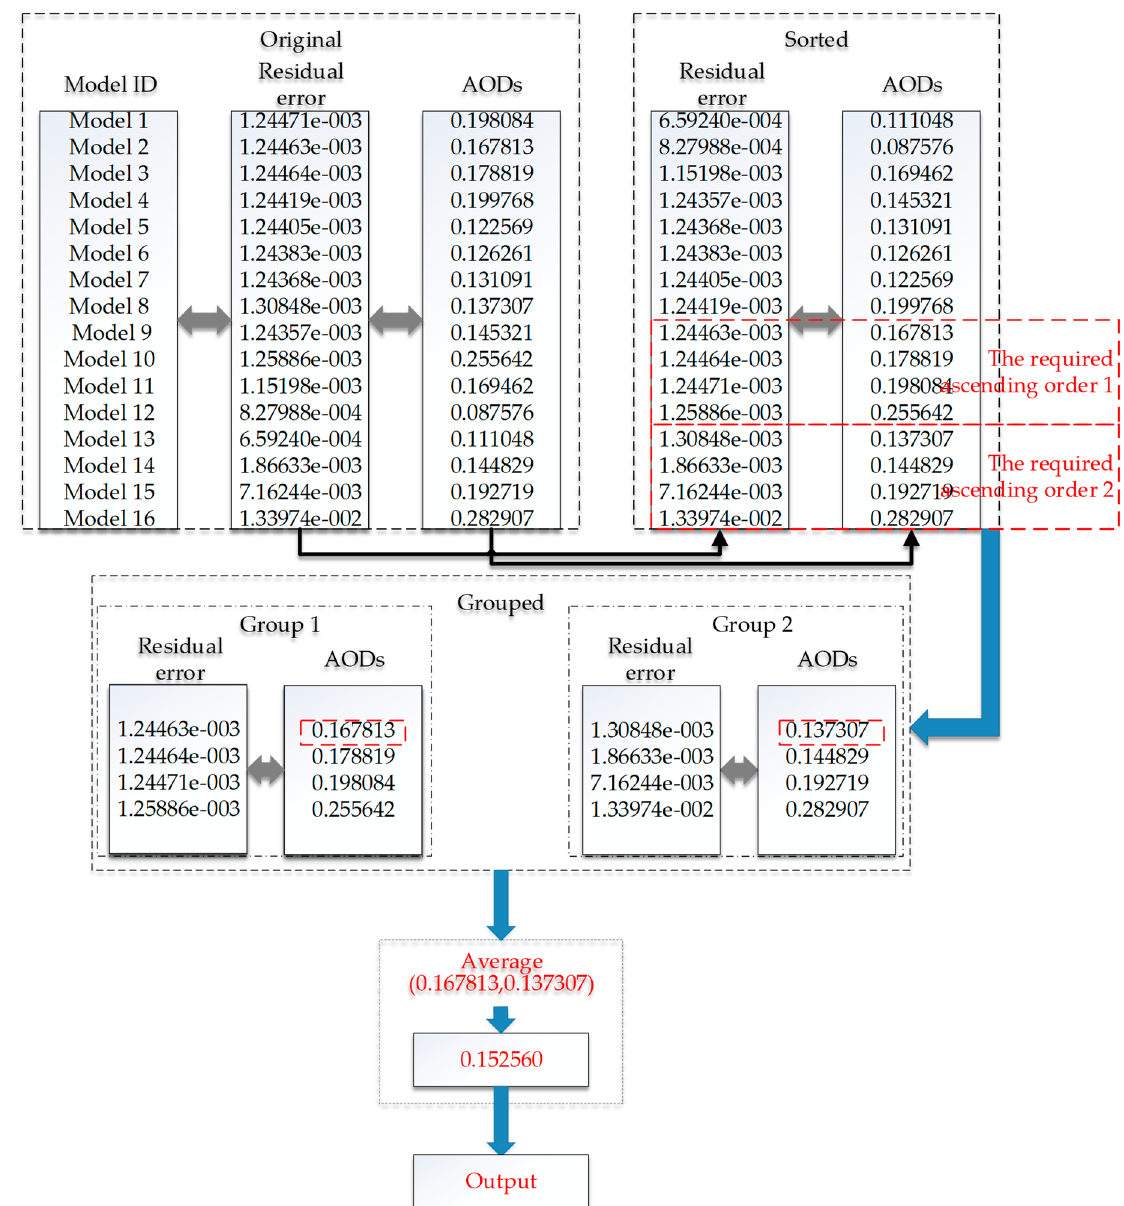
Figure 3. A brief application example of the GRES method.